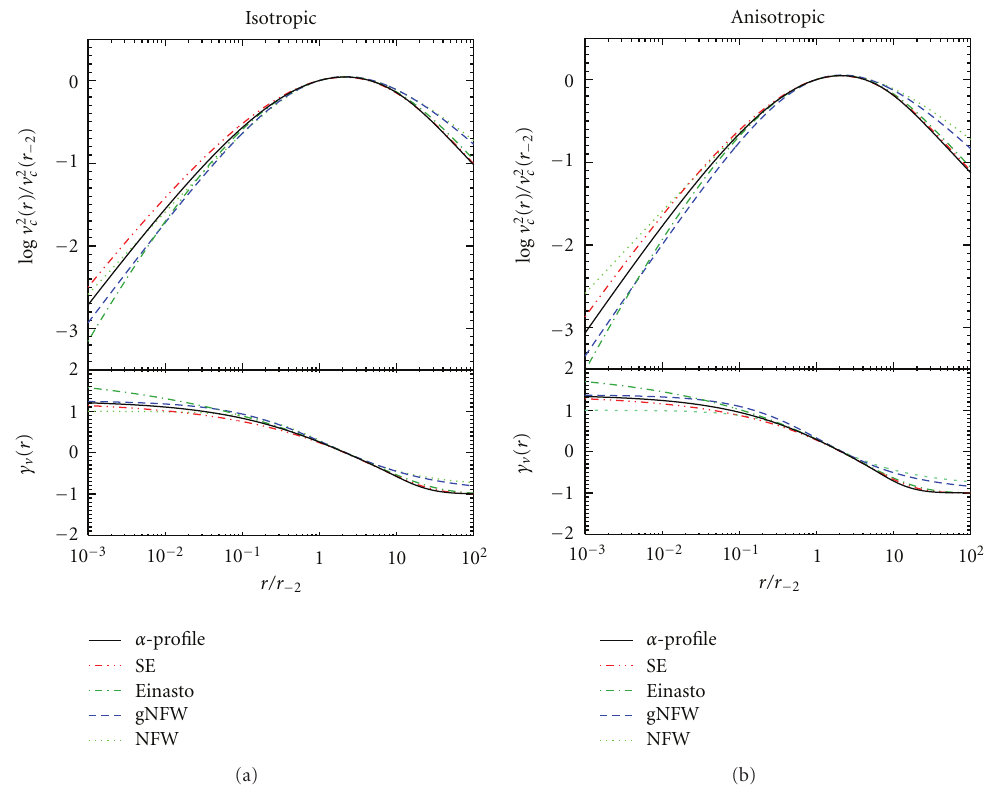
Figure 2: Same as Figure 1 for the profiles of circular velocity, and for the corresponding logarithmic slopes.